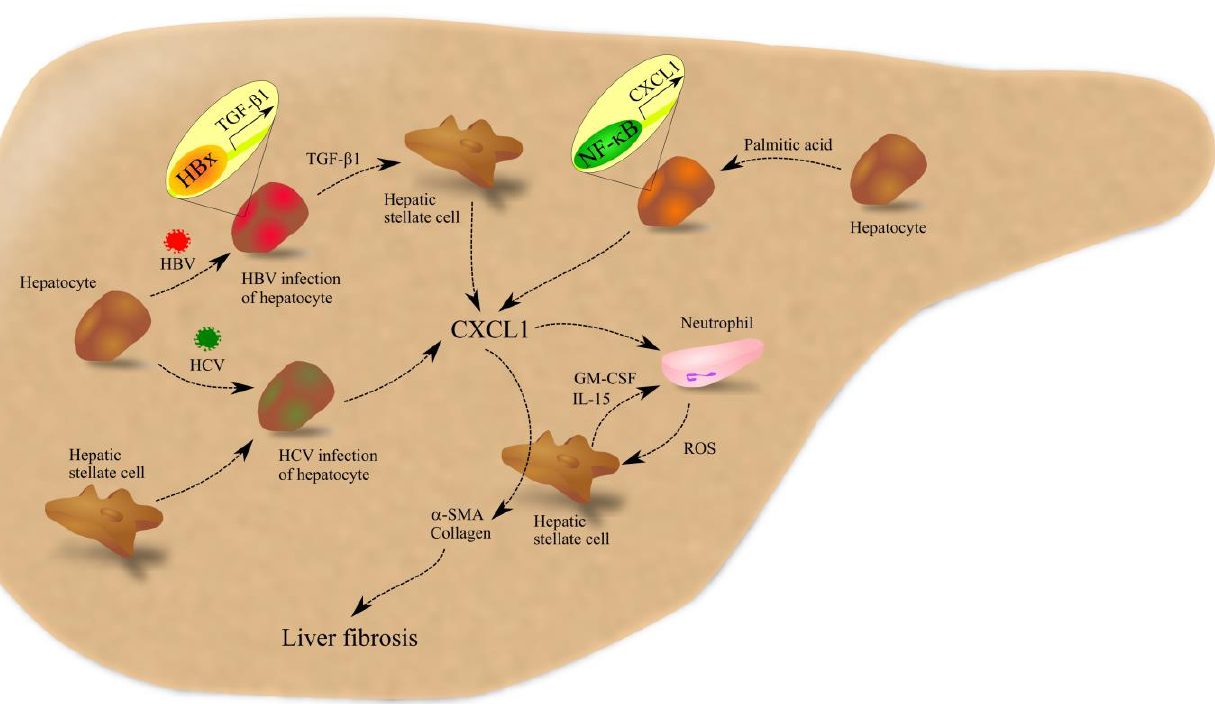
Figure 5. Involvement of CXCL1 in liver fibrosis. In the liver, CXCL1 is secreted by HCV-infected hepatocytes. This effect is enhanced by HSC. CXCL1 is also secreted by hepatocytes that contain too many saturated fatty acids as a result of an abnormal diet. In addition, HBV infection of hepatocytes increases the expression of TGF- β 1 in these cells, a result of the direct action of HBx viral protein on the promoter of the TGFB1 gene. TGF- β 1 increases the expression of CXCL1 in HSC. The aforementioned processes increase CXCL1 levels in the liver. This chemokine causes the recruitment of neutrophils to the liver. These cells secrete ROS, which causes activation of HSC, which secretes IL-15 and GM-CSF, which increase the viability of recruited neutrophils. Under